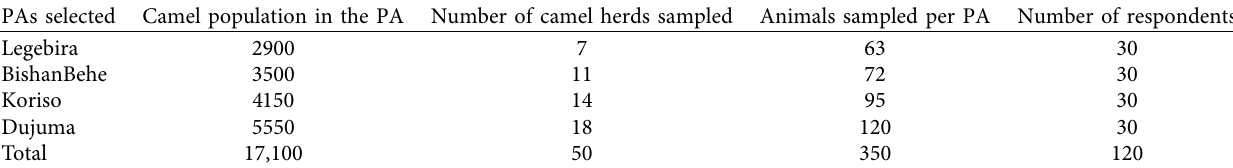
Table 1: Study population and sample size per